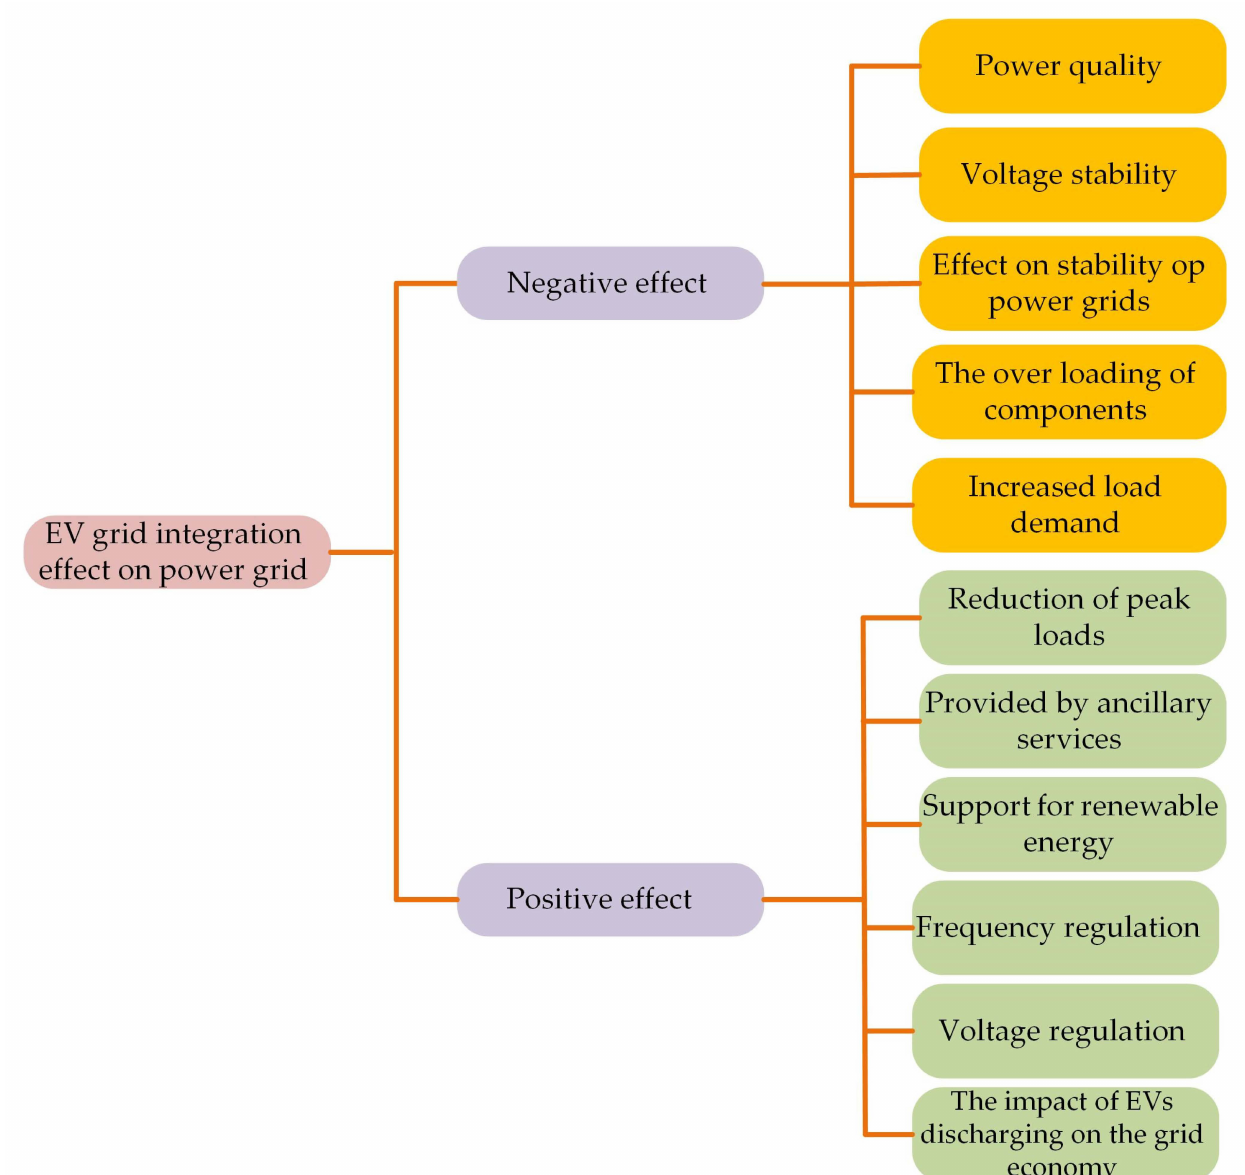
Figure 8. Examining the positive and negative effects of EVs when integrated with the power